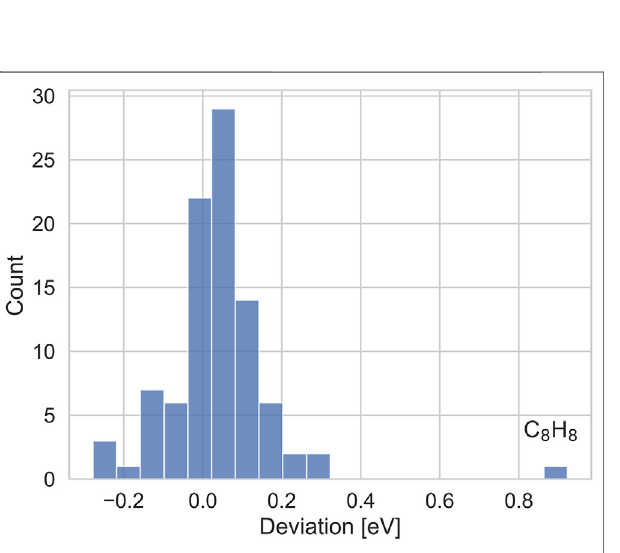
Frontiers in Chemistry |